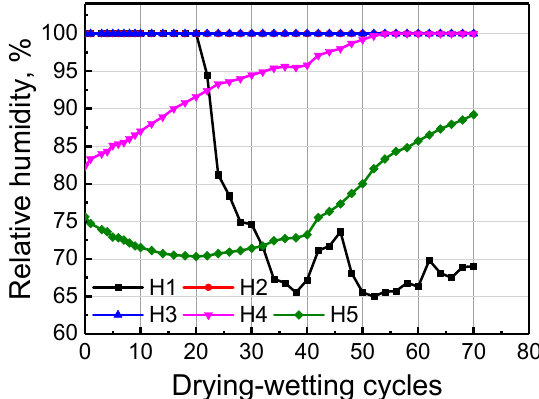
Figure 4. Development of interior relative humidity of mortar with dry-wet cycles.